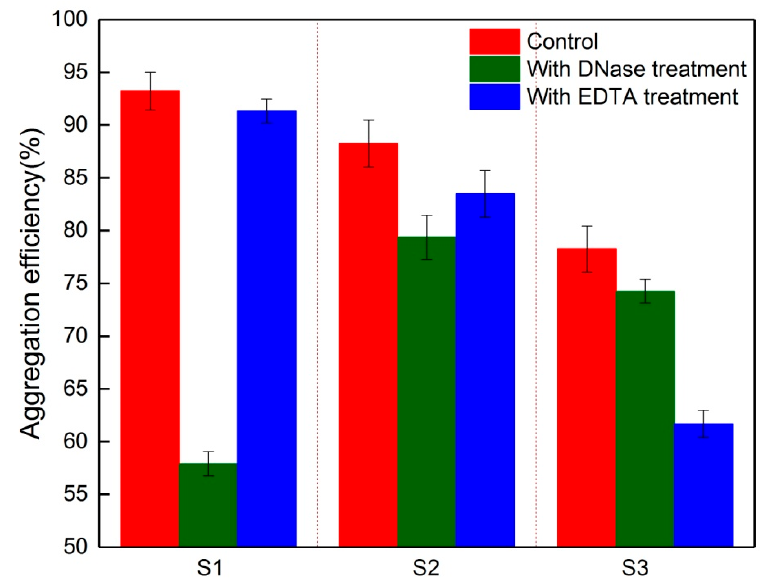
Figure 4. Aggregation efficiency of foulants without treatment after deoxyribonuclease (DNase) or ethylene diamine tetraacetic acid (EDTA) treatment.